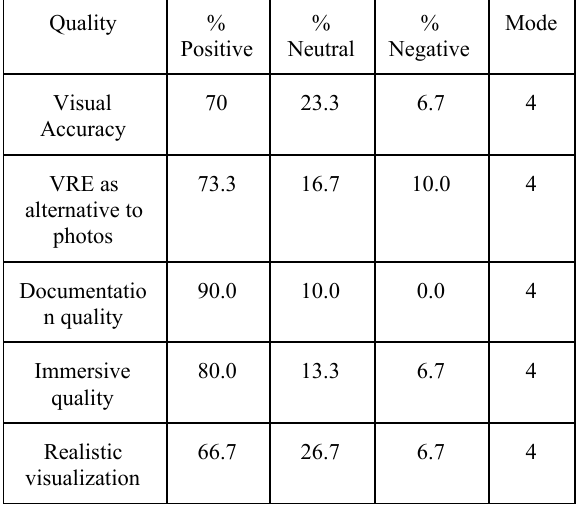
Table 7. Summary of ratings in survey